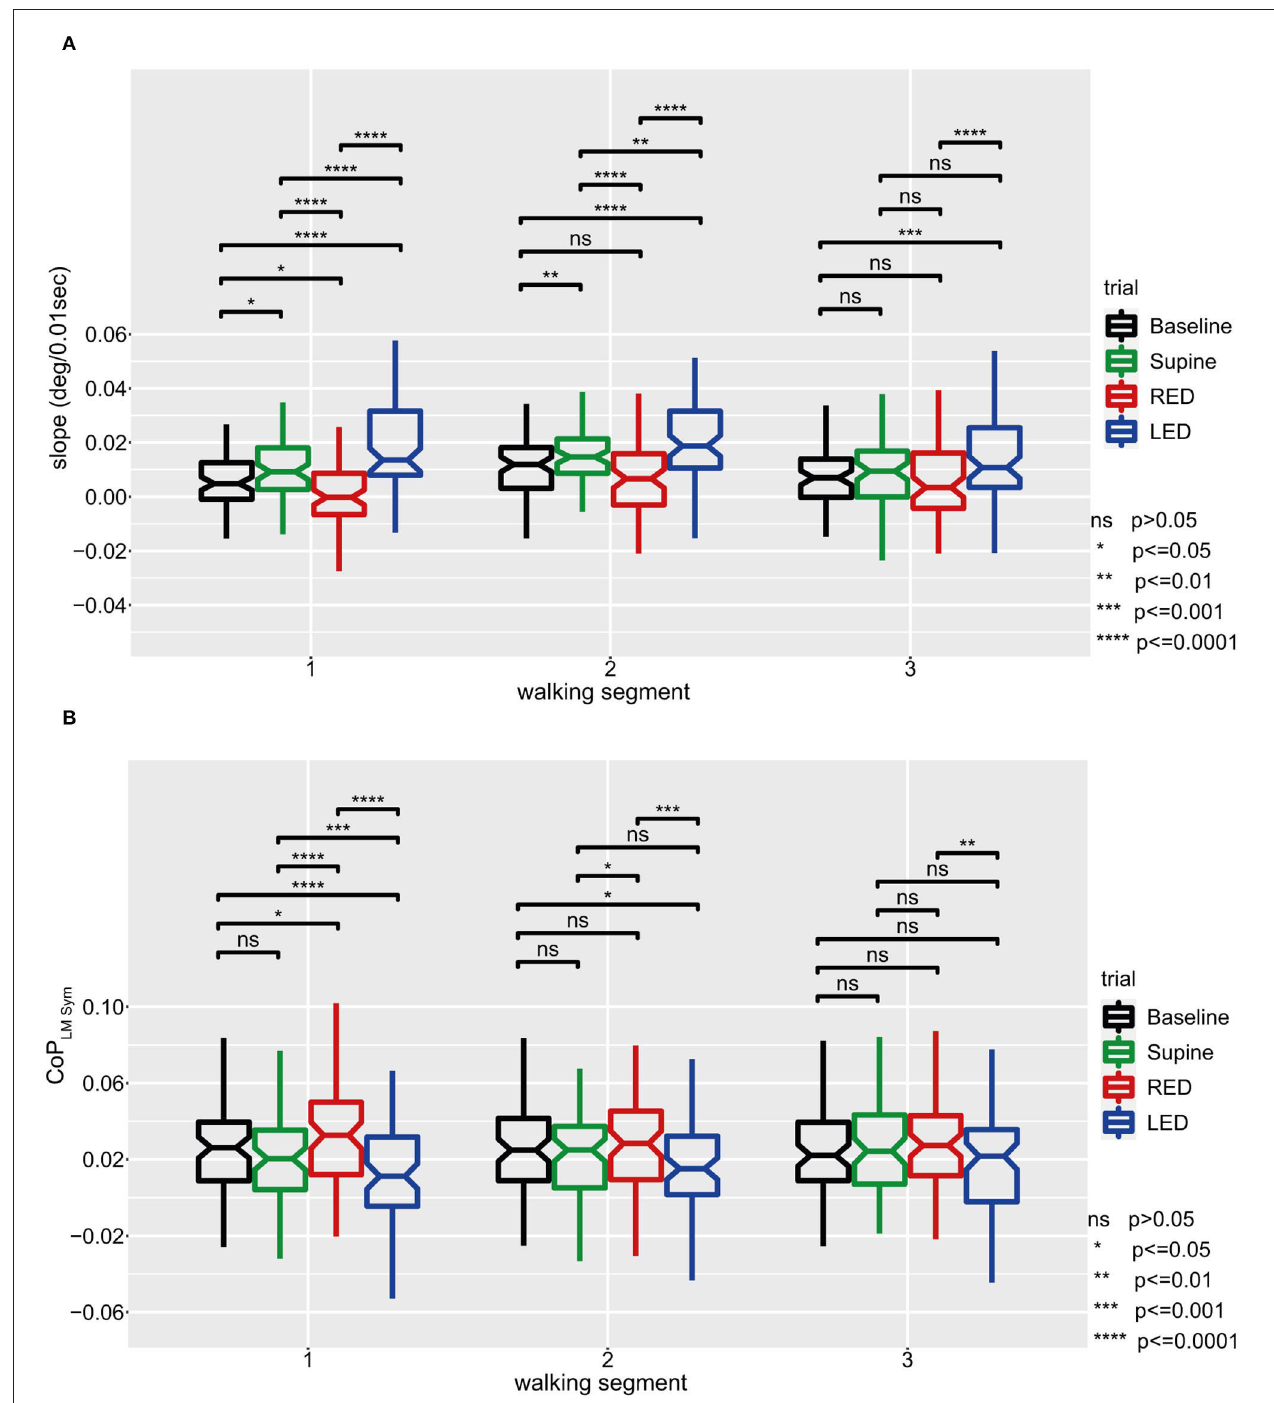
FIGURE 8 | The yaw slope (A) and averaged LM–CoP symmetries (CoP LM Sym , left to right foot) (B) and for all subjects and trials with pairwise comparisons between trials for the first three WS. For (A) , positive slopes indicate yaw rotations to the left side, negative slopes to the right side. For (B) , the results were calculated by subtracting the averaged CoP of the right foot from those of the left foot. Baseline values are hardware related and subject specific and should not be interpreted but used as a reference value. Positive changes between two measurement conditions or WS represent a shift of weight to the right side, negative changes to the left side. For both panels, linear mixed-effects models were calculated for every WS in which all trials were compared pairwise. Comparisons and p -value adjustments according to Tukey are displayed on top of the boxplots according to the legend on the lower right. Boxplot details: Lower and upper edges of the boxes depict the boundaries between the 25th and the 75th percentile of the data. The lines inside the boxes represent the median for every trial. Each whisker has at most a length of 1.5 times the interquartile range (box length). Data points outside of this limit are marked as separate points. Extreme points (i.e., further apart than 3*IQR) were classified as outliers and disregarded for the analysis. An inlet (placed right to the figure) provides the level of significance by using different numbers of * symbols.